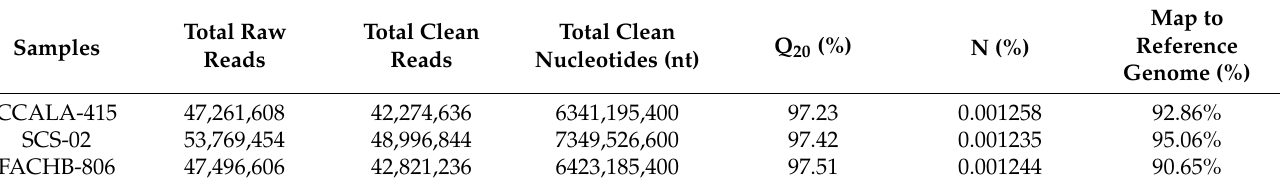
Table 3. Summary of output statistics by Illumina 2000 sequencing for three stains of Porphyridium .